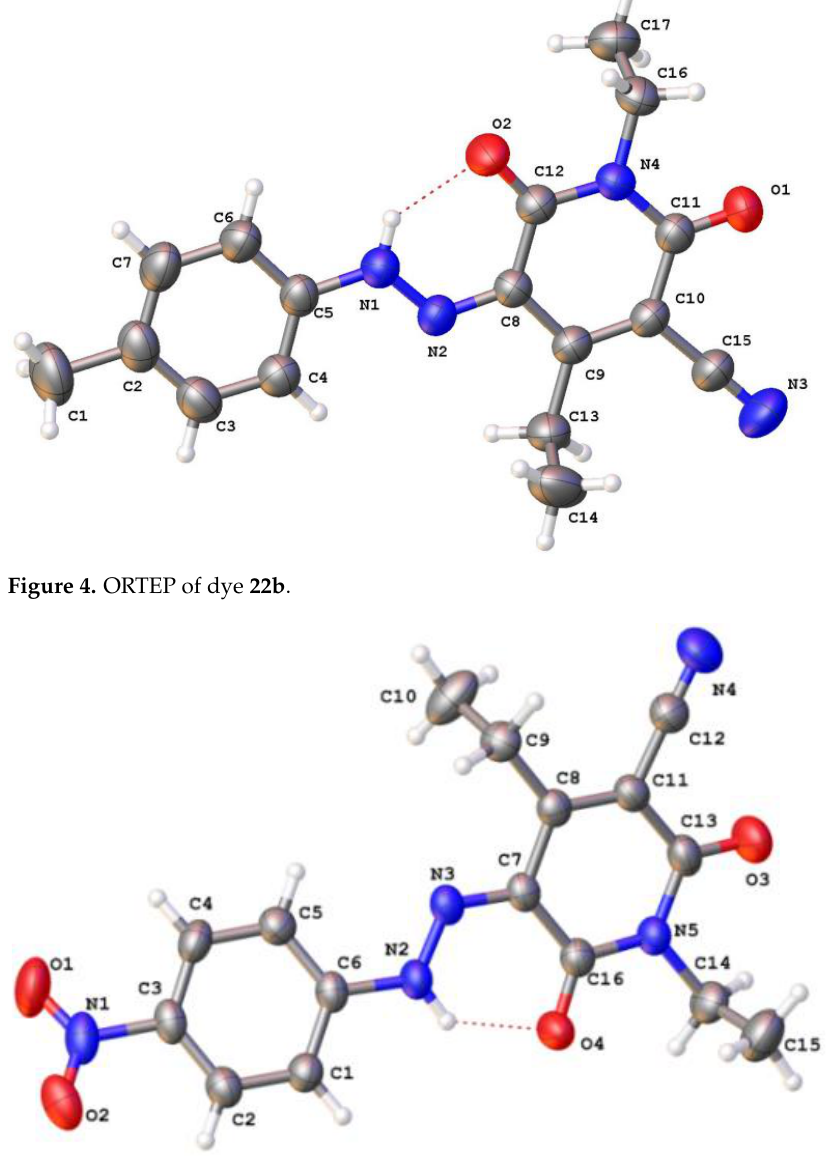
Figure 5. ORTEP of dye 22g.